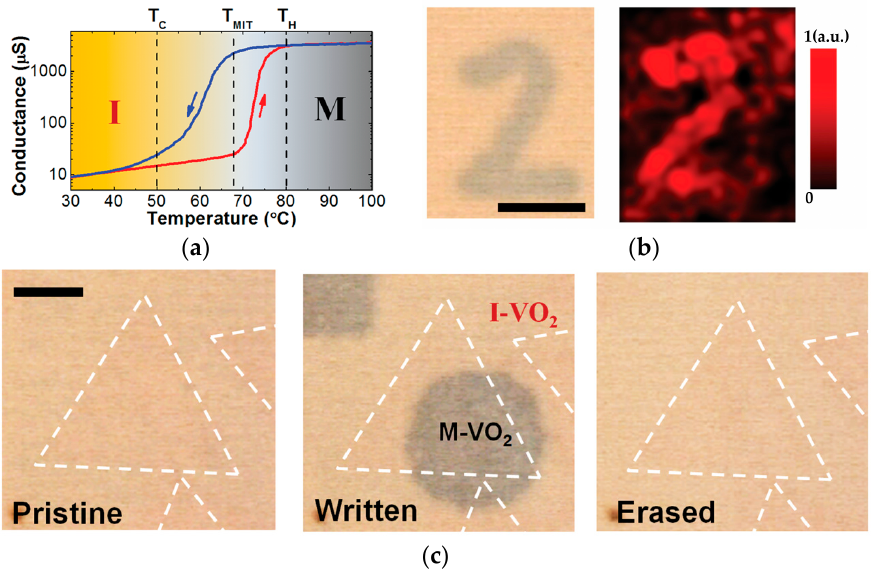
Figure 8. Writing and erasing desired patterns on VO 2 to modulate the PL intensity of MoS 2 . ( a ) Temperature dependence of electrical conductance of a typical VO 2 film; ( b ) Laser-writing induced metallic regions with a shape of “2” on an insulating VO 2 film covered by a MoS 2 monolayer; ( c ) Laser writing a metallic VO 2 circle, which enhances the PL intensity of the overlayer MoS 2 (Jiwei Hou et al. [64]).